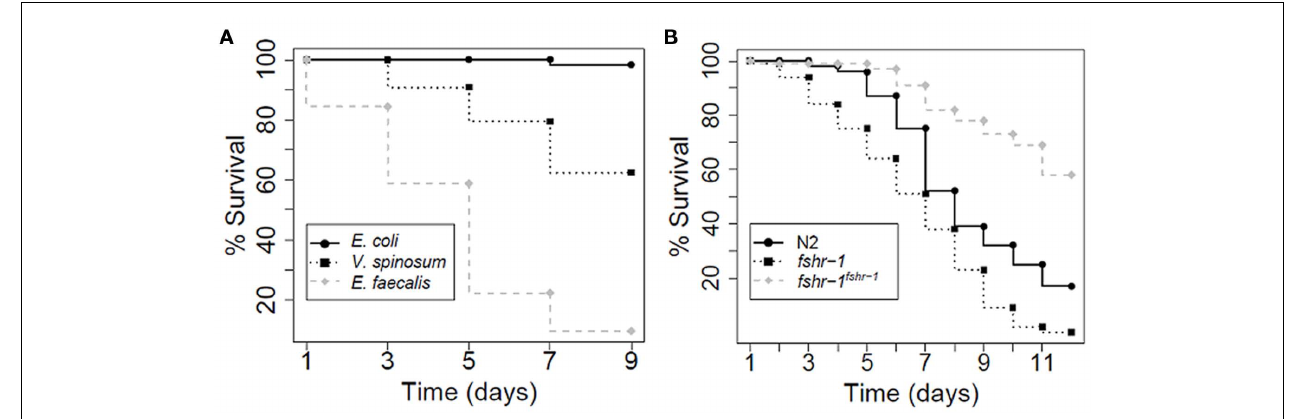
2.33e − 15 for V. spinosum ). (B) When exposed to V. spinosum , worm mutants hypersensitive to pathogens ( fshr-1 ) died faster than N2 wild-type worms